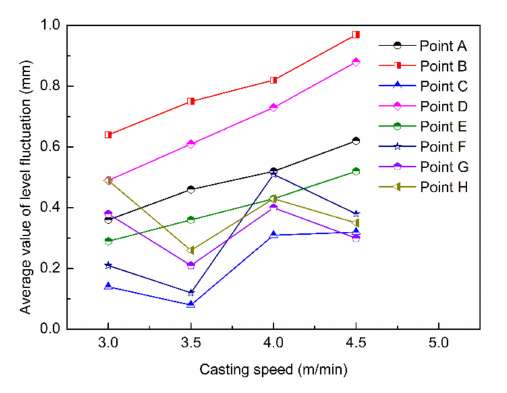
Figure 8. The average level fluctuation in the free surface at various measurement points.